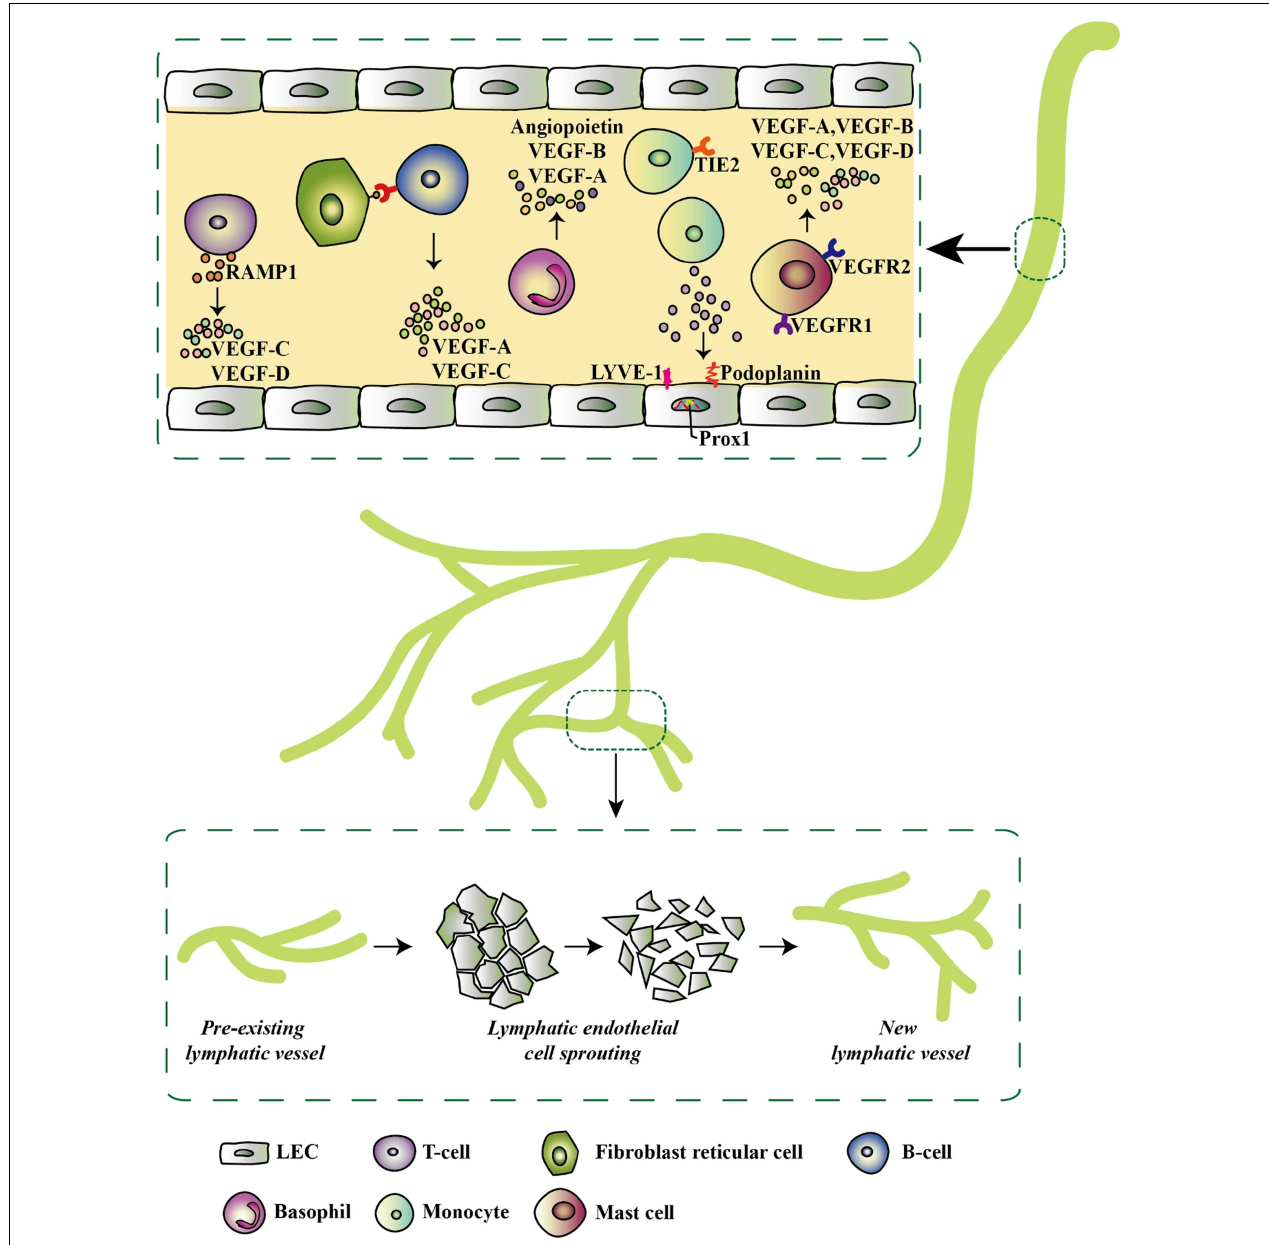
FIGURE 4 | Inflammatory-associated cells and their secretome that initiates lymphatic expansion, reproduced from Ocansey et al. (2021). Most of the inflammatory cells do not only secrete lymphangiogenic factors but also exhibit lymphangiogenic phenotypes by expressing specific lymphatic endothelial markers such